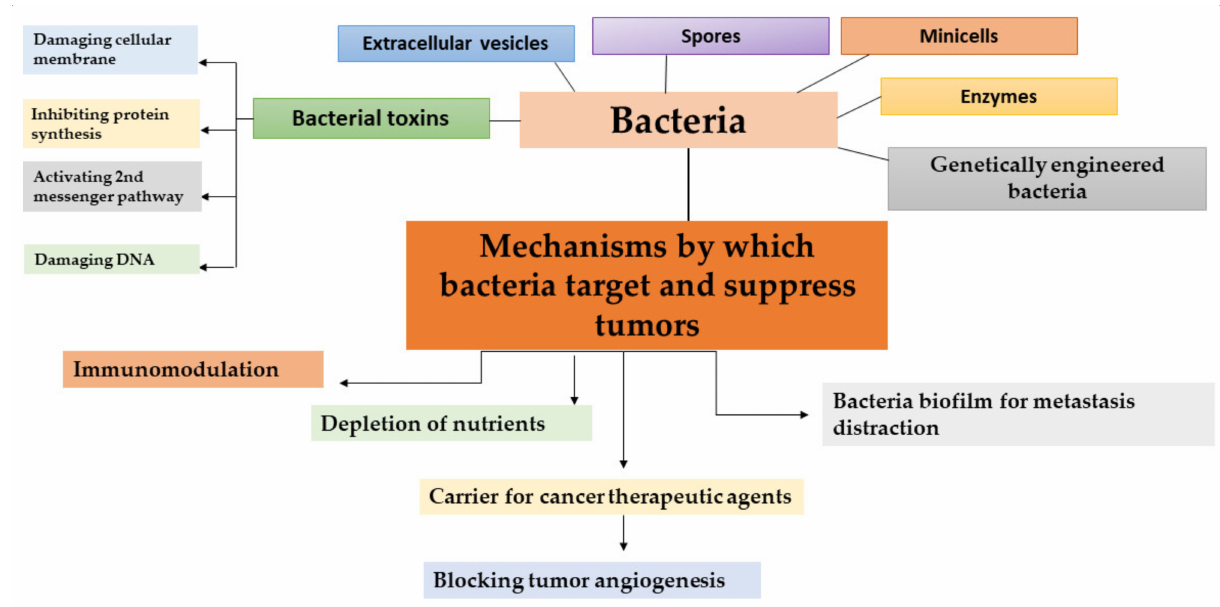
Figure 1. Different strategies in bacteria-based cancer therapy together with mechanisms by which bacteria and bacterial toxins target and suppress